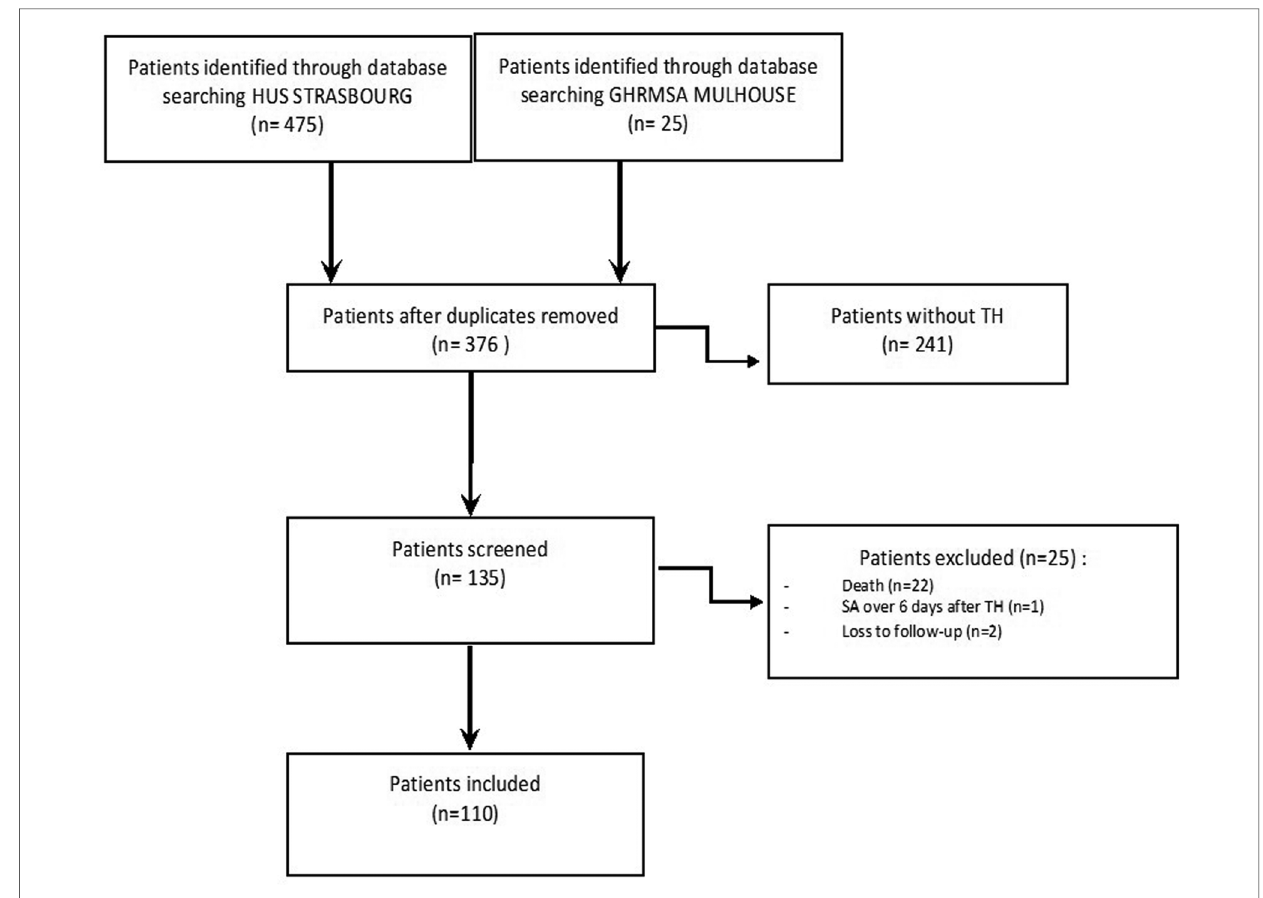
FIGURE 1 Flow of study